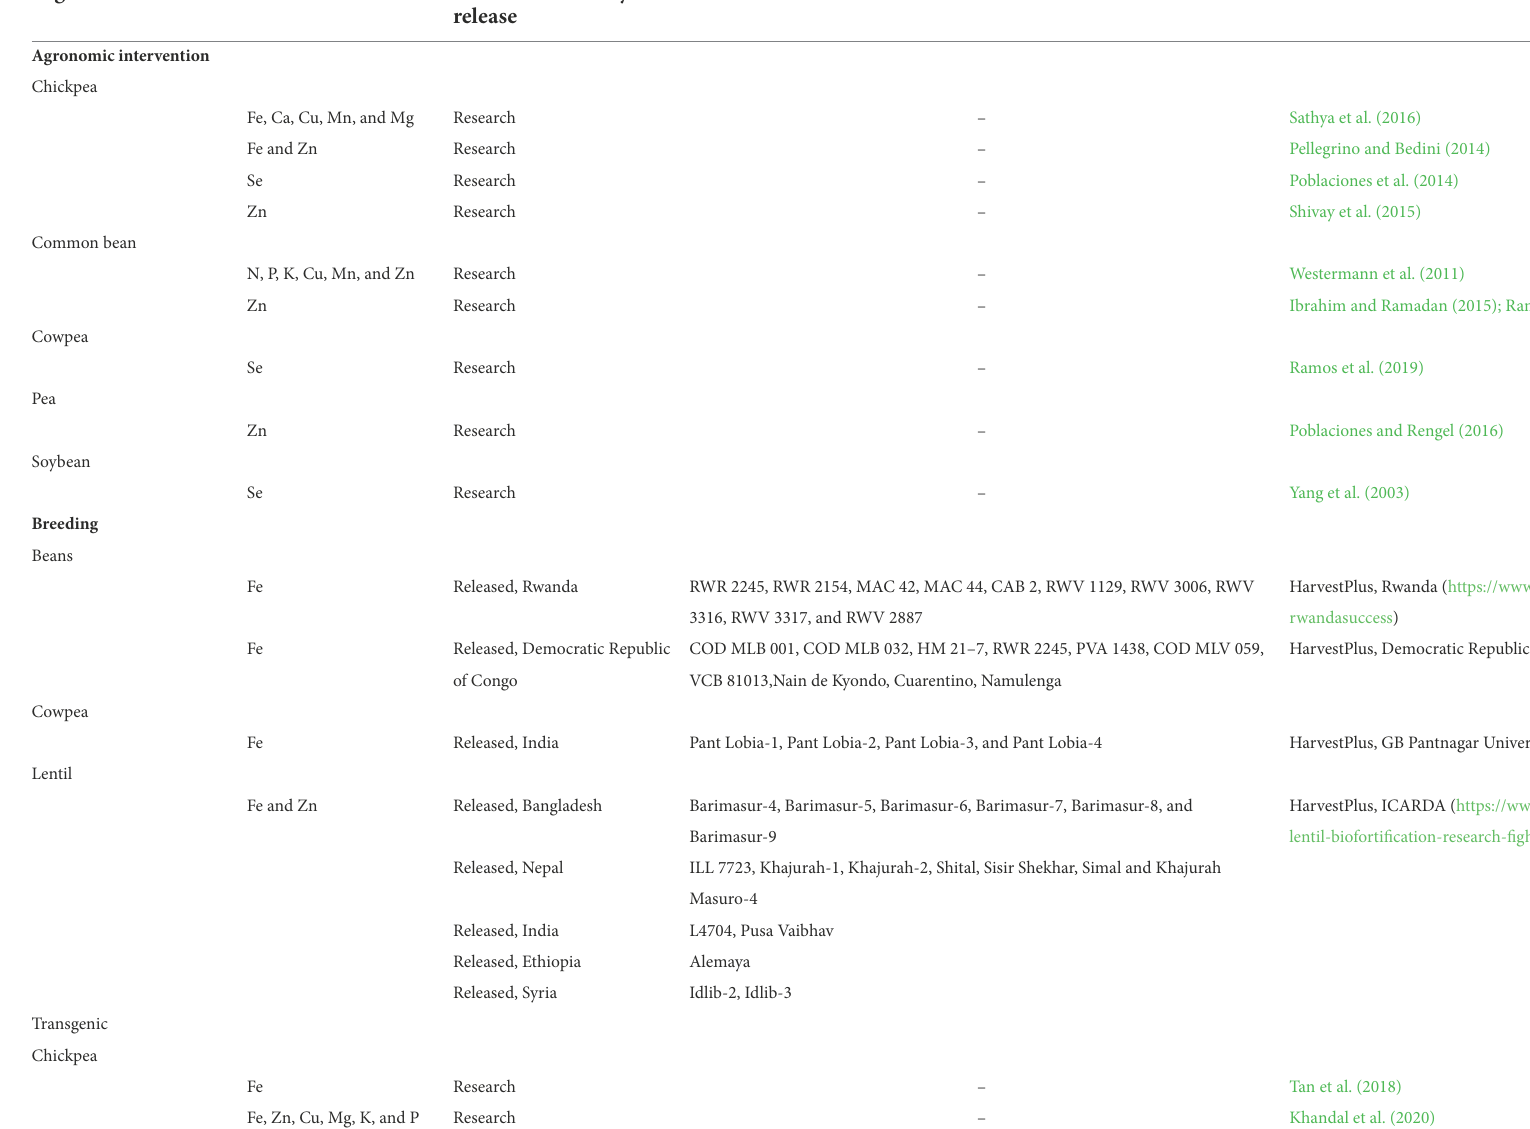
TABLE 3 Varieties/technologies in legumes through different biofortification